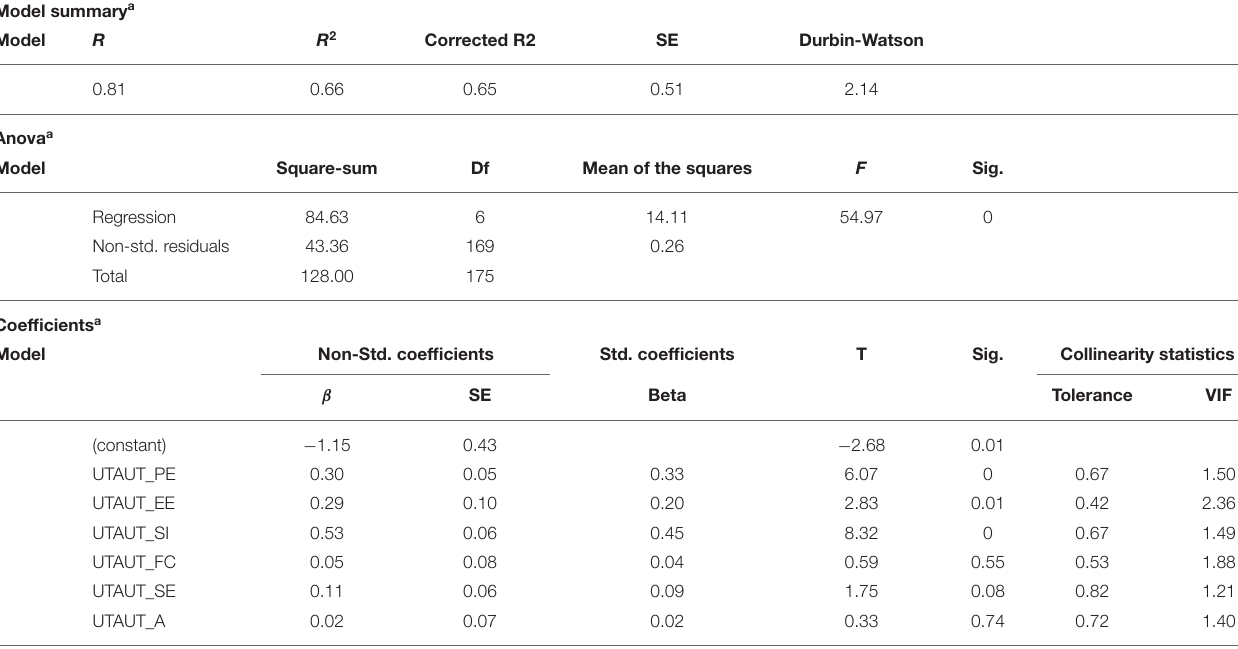
TABLE 5 | Influence of independent variables on behavioral